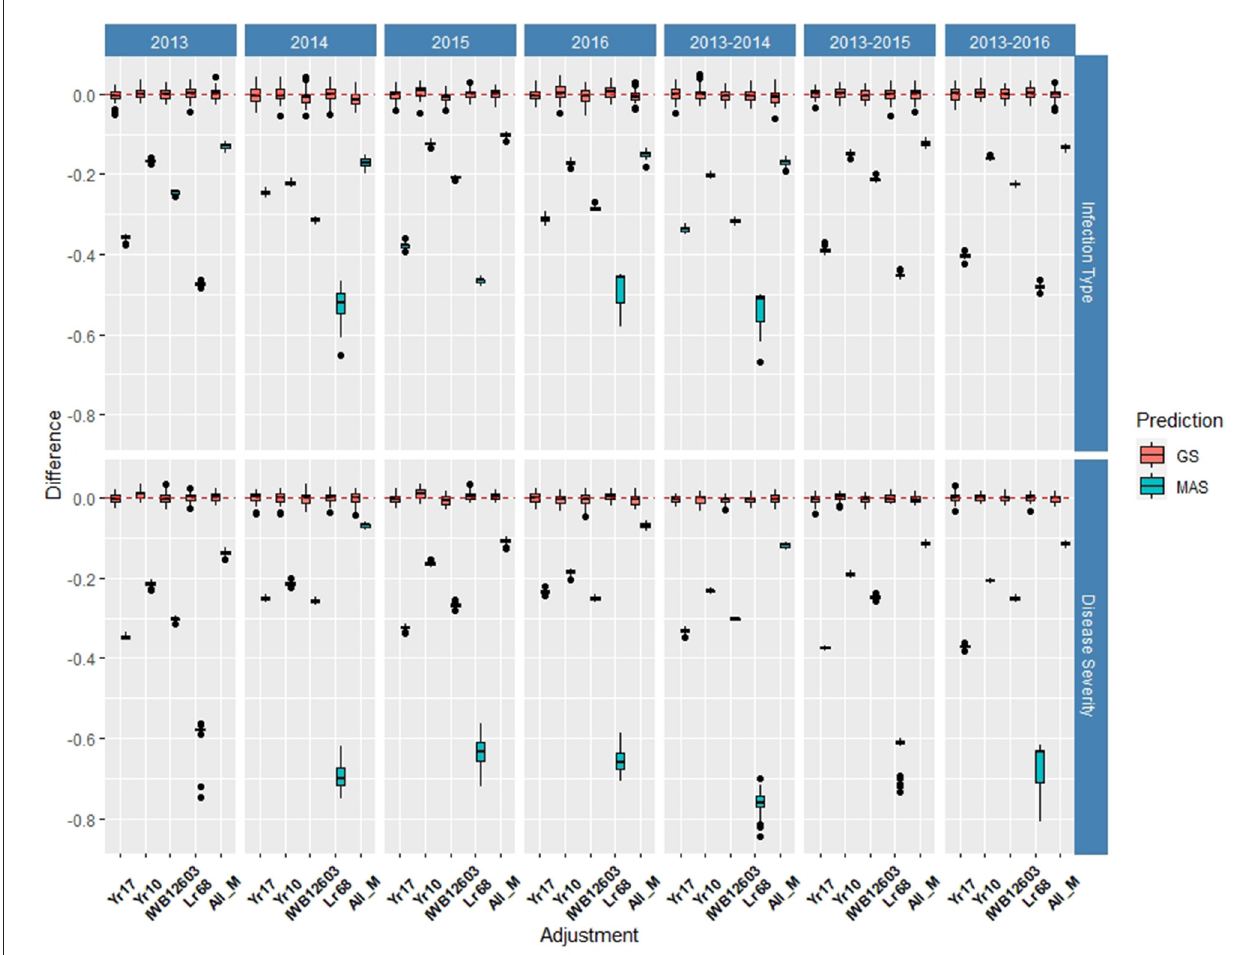
FIGURE 5 | Difference in prediction accuracy from the base rrBLUP model for major markers in GS and MAS using cross-validations in the diversity panel (DP) lines phenotyped from 2013 to 2016. Adjustments: ALL_M, IWB12603(Qyr.wpg-1B.1), KASP(Lr68), Xpsp3000(Yr10), and KASP(Yr17)